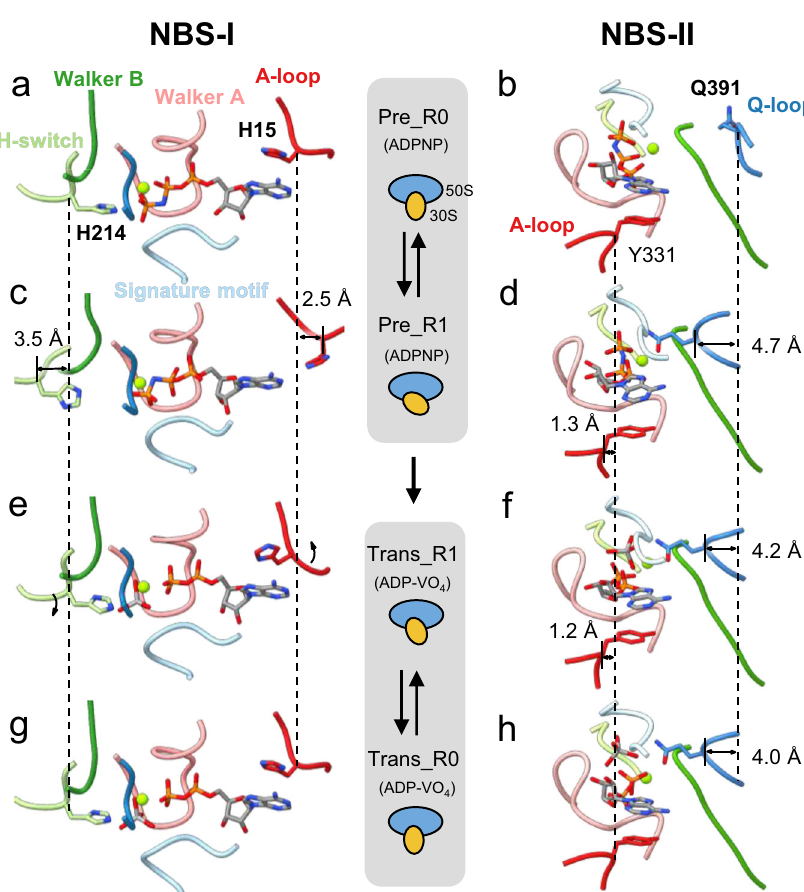
Fig. 5 Asymmetric nucleotide engagements in the pre-hydrolysis states. Nucleotide engagements in the NBSs for the Pre_R0 ( a and b ), Pre_R1 ( c and d ), Trans_R1 ( e and f ), and Trans_R0 ( g and h ) states. Different ATP-binding/hydrolysis motifs are colored and labeled as in panel ( a ). Magnesium is shown as a sphere and colored lime. Cartoons in-between the two columns indicate different states of the 70SIC-MtbEttA complex and different degrees of the 30S rotation. Dashed vertical lines aid the measurement of the shift of corresponding C α atoms between different